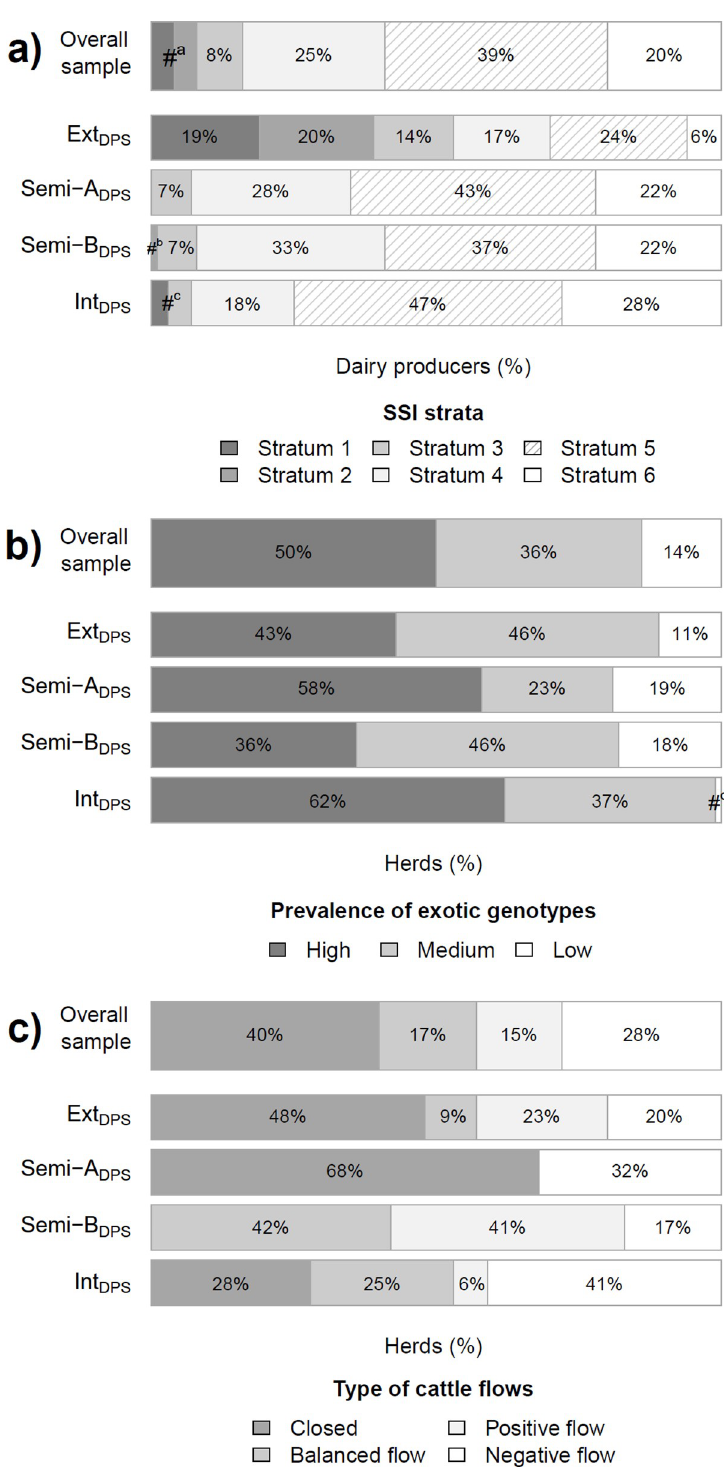
Fig 2. Frequency of a) dairy producers (%) according to the urbanization level of the dairy farm’s surroundings (P SSI; stratum 1 = urban to stratum 6 = rural), b) herds (%) according to the prevalence of exotic genotypes within the herd (P-GEN) and c) herds (%) according to the type of cattle flows within the herd (P-FLOW), overall and for each dairy production system (DPS). # a = 4% each for stratum 1 and 2 in the overall sample; # b = 1% for Semi-B DPS stratum 2; # c = 3% for Int DPS stratum 1 and 4% for Int DPS stratum 3; # d = 1% for Int DPS , low prevalence.